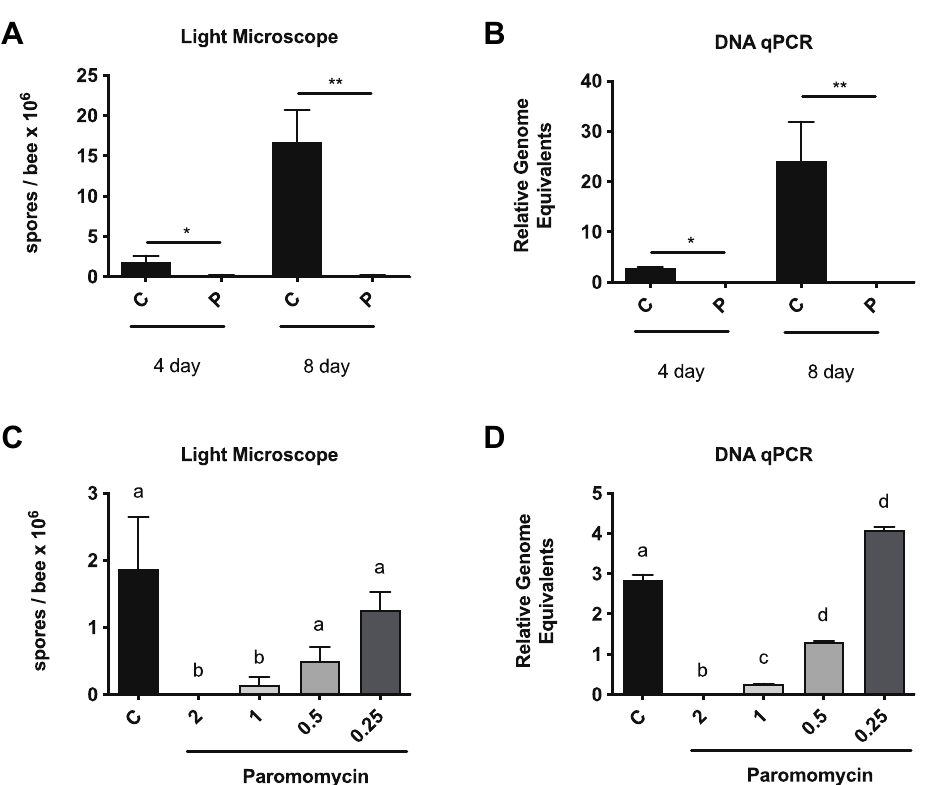
Figure 1. Paromomycin treatment reduces V. ceranae infection levels in newly emerged bees and colony bees . V. ceranae levels in the midguts of infected newly emerged bees fed with a sucrose solution with ( n = 14) or without ( n = 14) paromomycin for 4 or 8 days, as determined by spore count using light microscopy ( A ) or qPCR ( B ). V. ceranae levels in the midguts of infected newly emerged bees fed with a sucrose solution containing various doses of paromomycin ( n = 15, 2 mg/mL; n = 14, 1 mg/mL; n = 14, 0.5 mg/mL; n = 12, 0.25 mg/mL) for 4 days, as determined by spore count using light microscopy ( C ) or qPCR ( D ): Statistical significance is noted as * for p < 0.05 and ** for p < 0.01 or a ≠ b ≠ c ≠ d; p < 0.05.